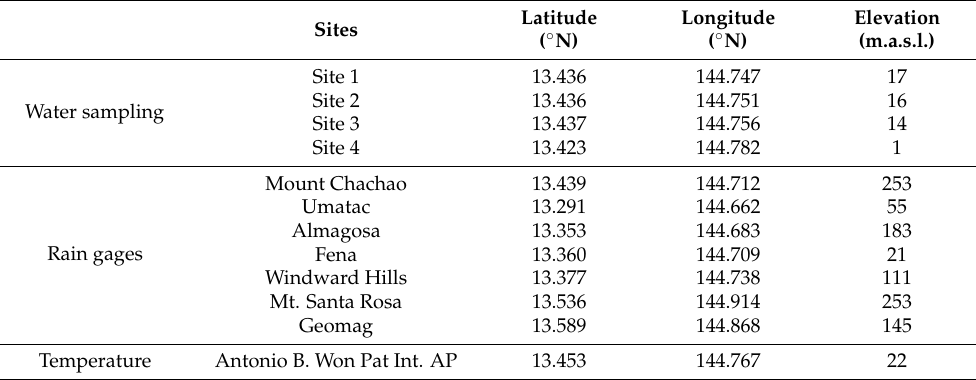
Figure 1. Geographical information on the study area (Pago Watershed) in Guam. ( A ) location of the island of Guam in the Pacific Ocean, ( B ) location of the island in the Mariana region, ( C ) location of the Pago Watershed in Guam, and ( D ) the study area which encompasses the Pago Watershed, including the Lonfit, Sigua, and Pago rivers. Red points denote the rain gages in ( C ) and sampling sites in ( D ) for water quality tests. Sources for World Ocean Reference and Bases in ( A – C ) are Esri, GEBCO, NOAA, National Geographic, Garmin, HERE, Geonames.org, and other contributors. Table 1. Geological information on the water sampling sites and observed data (rain gauges, and temperature, and